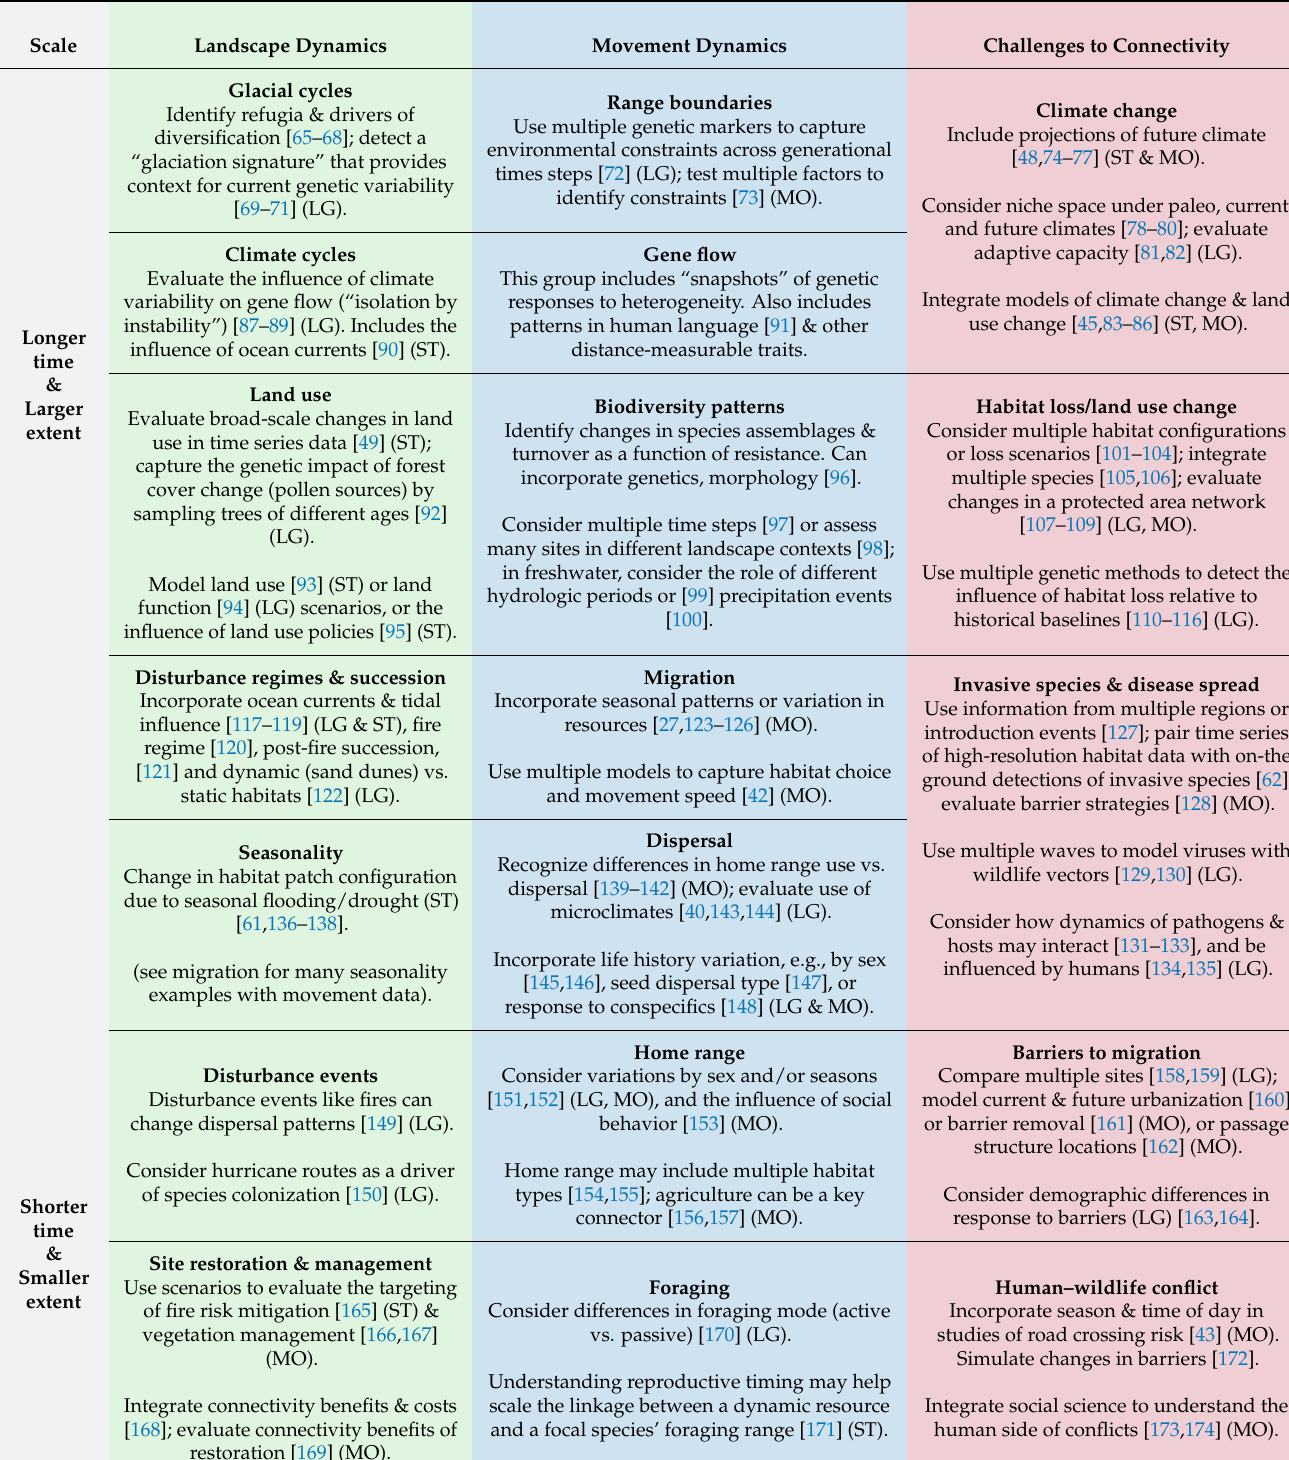
Table 1. Examples of dynamic elements within Circuitscape applications, as grouped in the dynamic connectivity topics presented in Zeller et al.’s framework [30]. The three main columns describe key research themes; topics are arranged according to focal temporal and spatial scales (large to small, see “scale” column), and the color scheme links columns to the same research themes and topics in Figure 2. Circuitscape application types are labeled as “LG” for landscape genetics, “MO” for species movement data & habitat models, and “ST” for studies focused on generalized landscape